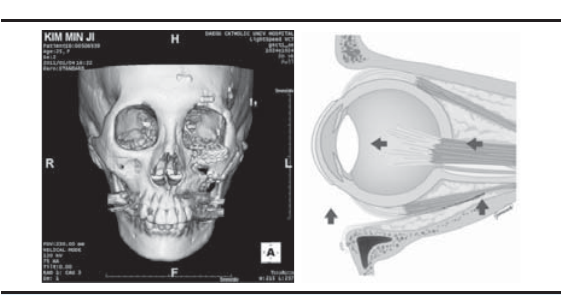
Figure 6. Frontal view of 3D computer tomogram six months after surgery Titanium mesh is well positioned and the zygoma osteotomy site is well-united